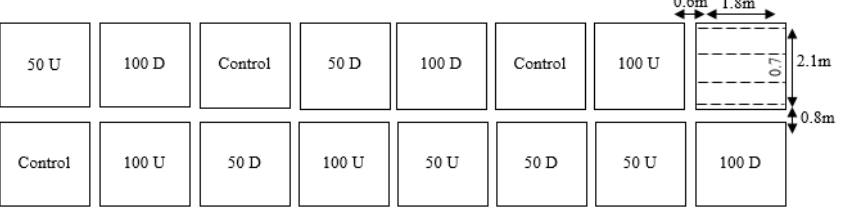
Figure 1. Experimental design with different N-fertilization levels: Control (0 kg N ha −1 ); 50 D (50 kg N ha −1 as digestate); 100 D (100 kg N ha −1 as digestate); 50 U (50 kg N ha −1 as urea); 100 U (100 kg N ha −1 as urea).